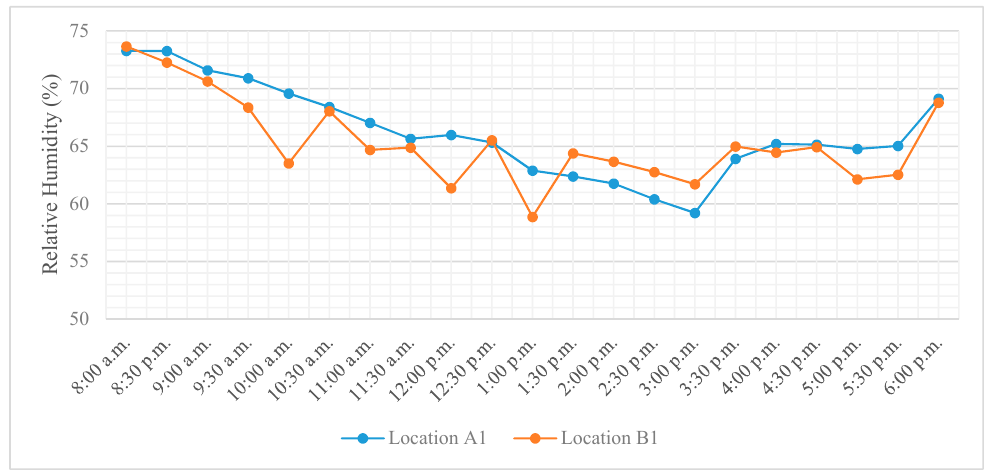
Figure 12. Indoor relative humidity in the lobby of Building A (Location A1) and Building B (Location B1).